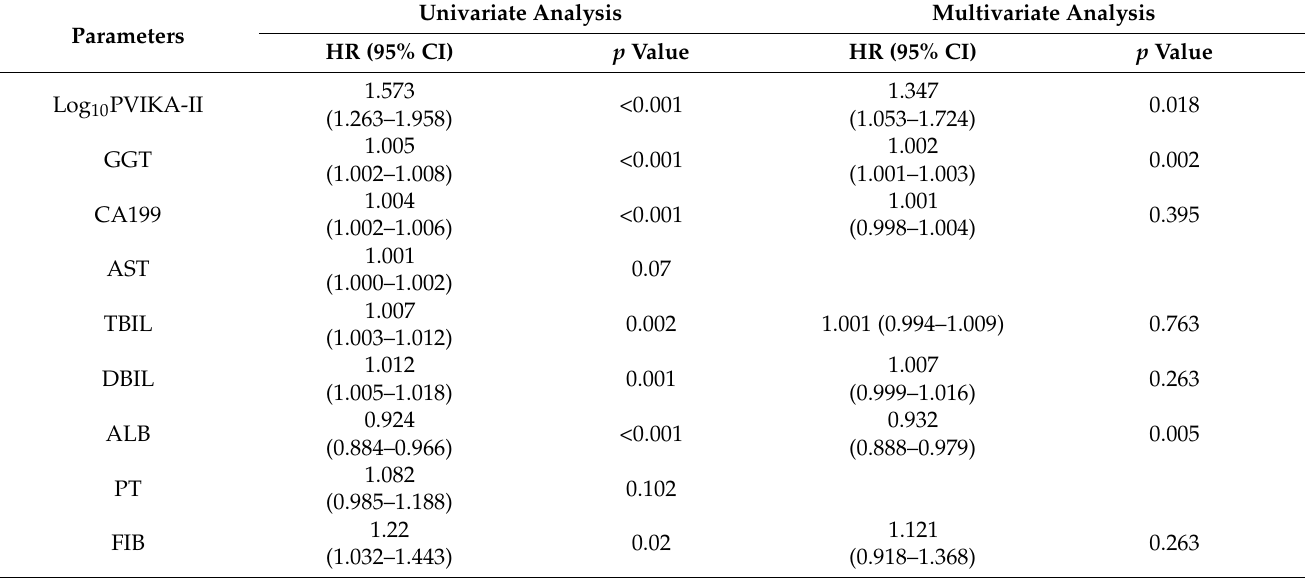
Table 4. Univariate and multivariate Cox regression analysis in HCC patients according to 3-year mortality.